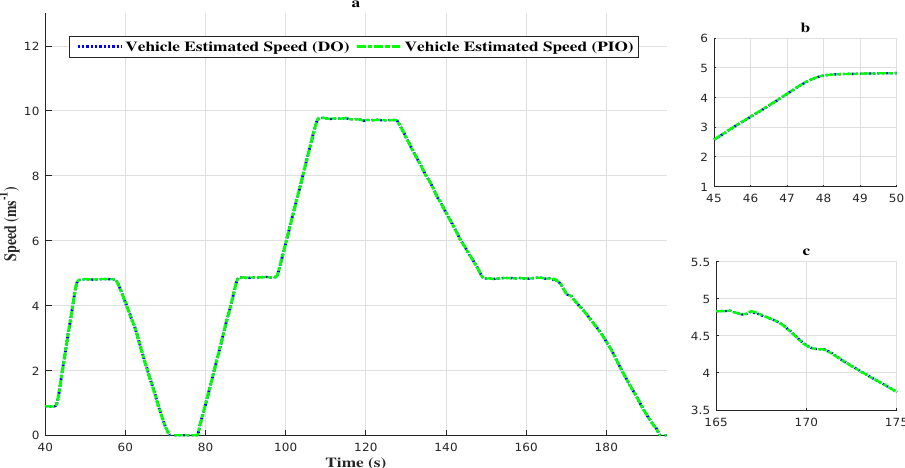
Figure 14. ( a ) Comparison of the vehicle estimated speed with the two observers. ( b ) Zoom in at t ∈ [ 45 s,50 s ] . ( c ) Zoom in at t ∈ [ 165 s,175 s ] .